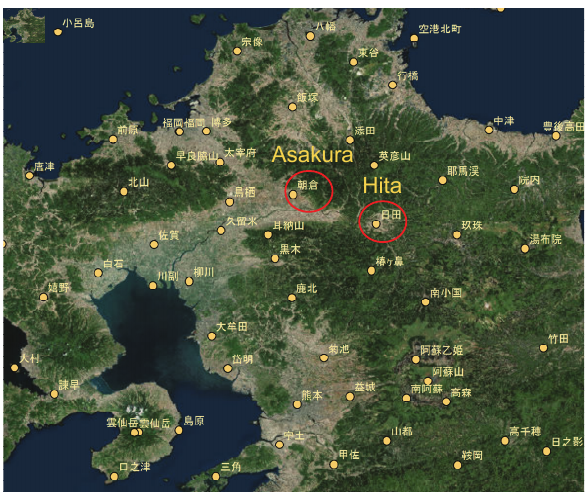
Figure 7. Information on observation point in the vicinity of the JMA AMeDAS stations at Asakura and Hita.